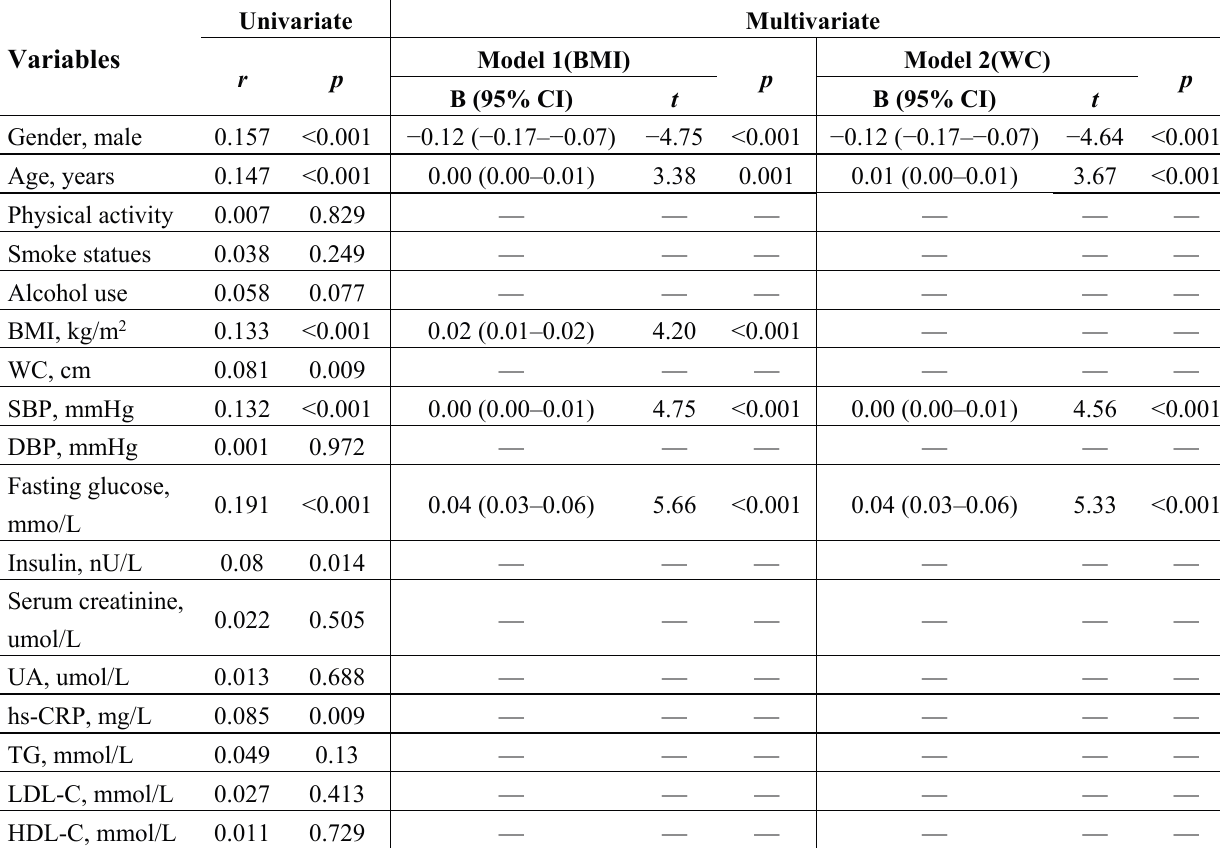
Table 3. Univariate and multivariate linear regression analysis for correlation between ACR and other variables in hypertensive subjects.